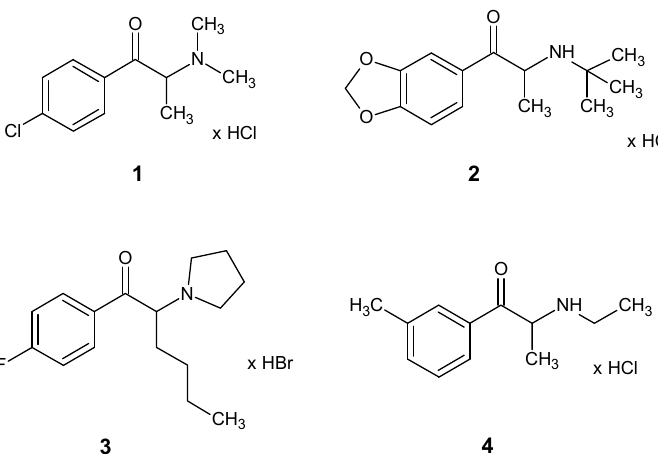
Figure 1. Structures of 1-(4-chlorophenyl)-2-(dimethylamino)propan-1-one hydrochloride ( 1 ), 1-(1,3- benzodioxol-5-yl)-2-(tert-butylamino)propan-1-one hydrochloride ( 2 ), 1-(4-fluorophenyl)-2- (pyrrolidin-1-yl)hexan-1-one hydrobromide ( 3 ) and 2-(ethylamino)-1-(3-methylphenyl)propan-1-one hydrochloride ( 4 ).